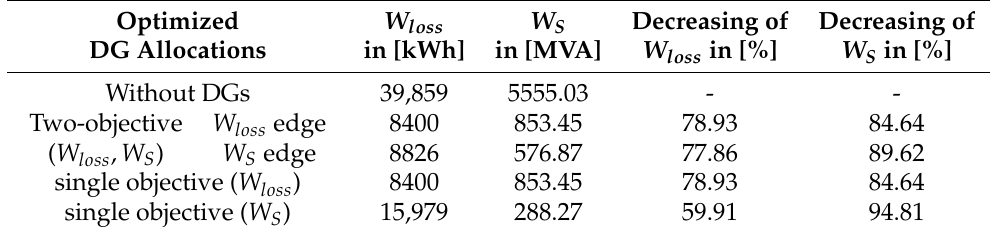
Figure 18. The Pareto front of the solved multi-objective optimization problem for Opt 3 (Figure 3). Table 4. Results for optimal solutions of Opt 1 optimization model for different objective functions (W1 workflow).